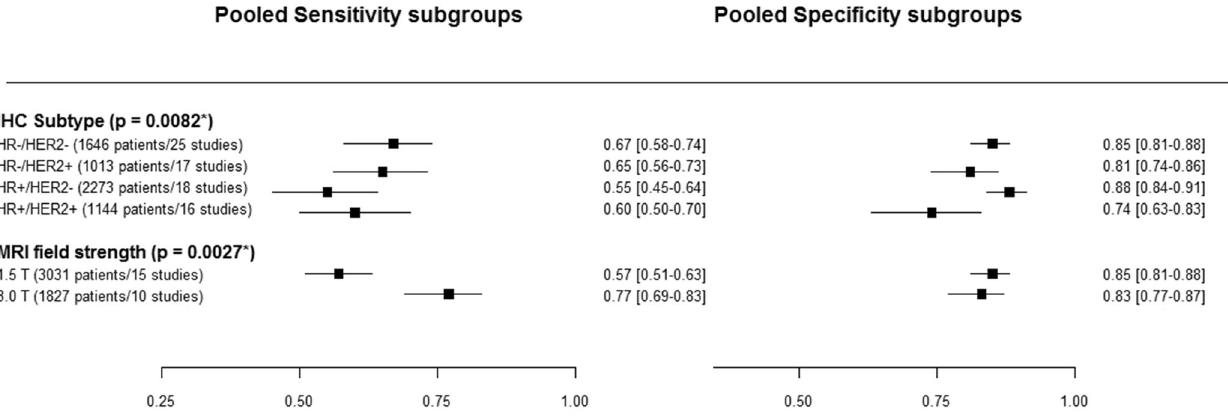
Fig. 2 Summary estimates for sensitivity and speci fi city and 95% CI for subgroups. P -values represent results from meta-regression analysis with a model containing only IHC subtype or only MRI fi eld strength.